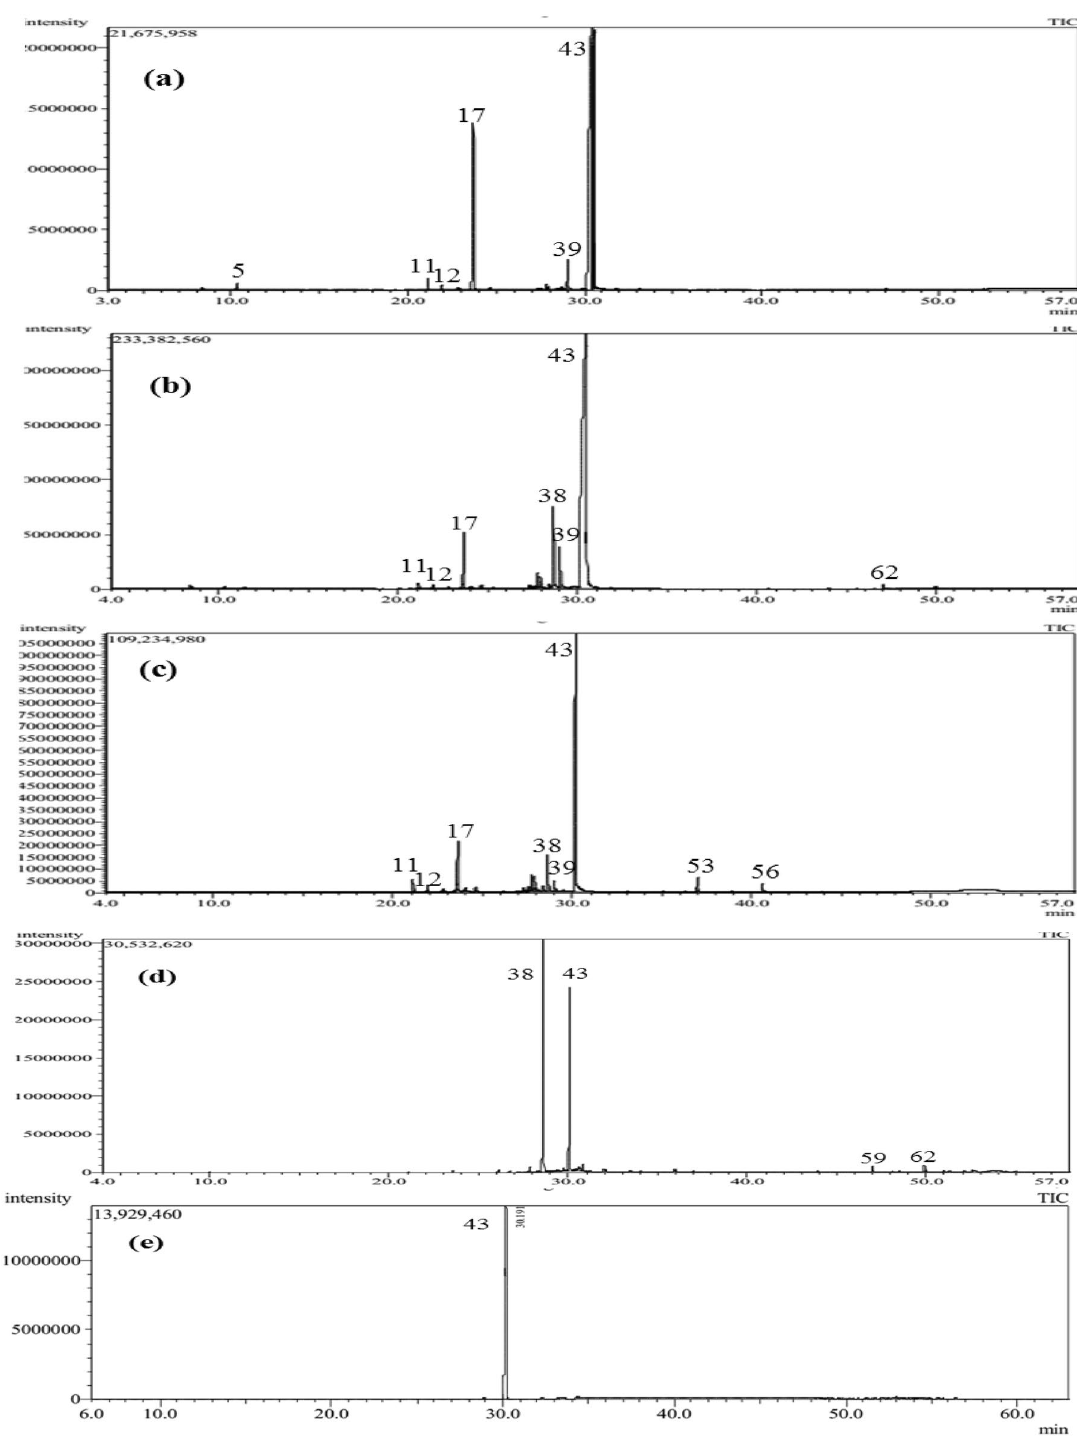
Figure 1. GC-chromatograms obtained with a Rtx-5MS column of the volatile constituents isolated by hydrodistillation from ( a ) B. daphnoides leaves, ( b ) B. daphnoides stems, ( c ) B. daphnoides flowers, ( d ) B. daphnoides fruits and ( e )